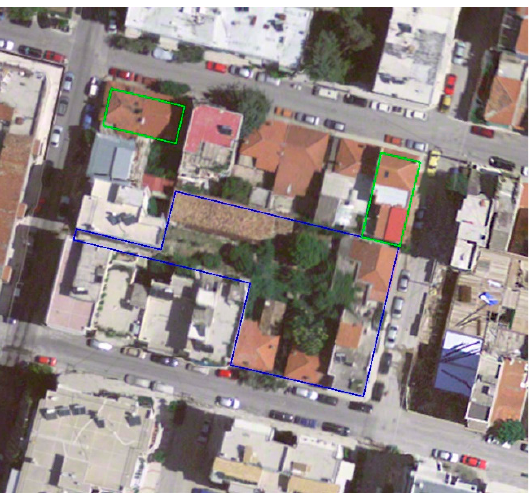
Figure 4. The study area, indicating the new merged land parcel (marked in blue) where the new building will be built and the land parcels of the CH buildings (marked in green).